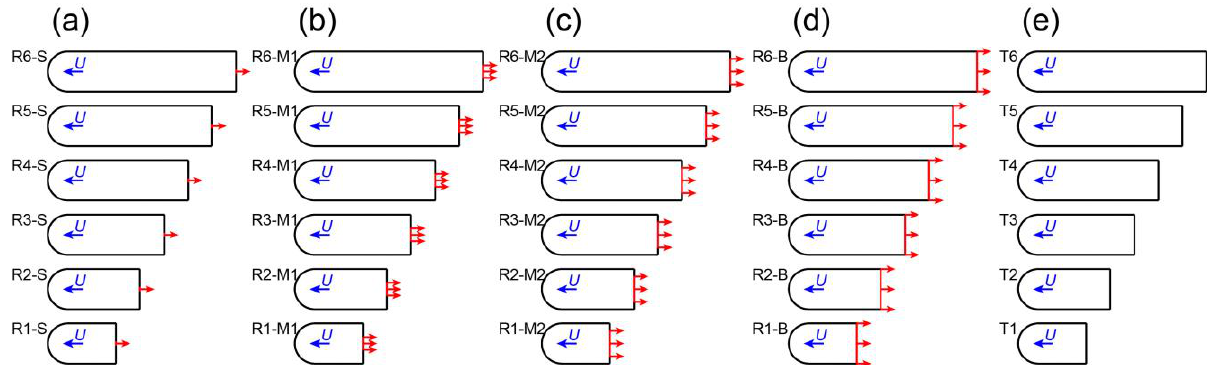
Figure 1. ( a – d ) Four groups of six jet-propelled axisymmetric bodies that have the same cross-sectional diameter but six different body aspect ratios combined with four different jet orifice sizes (i.e., four different Ω values). ( e ) A group of six towed axisymmetric bodies that have the same cross-sectional diameter but six different body aspect ratios. See the main text for detailed descriptions.